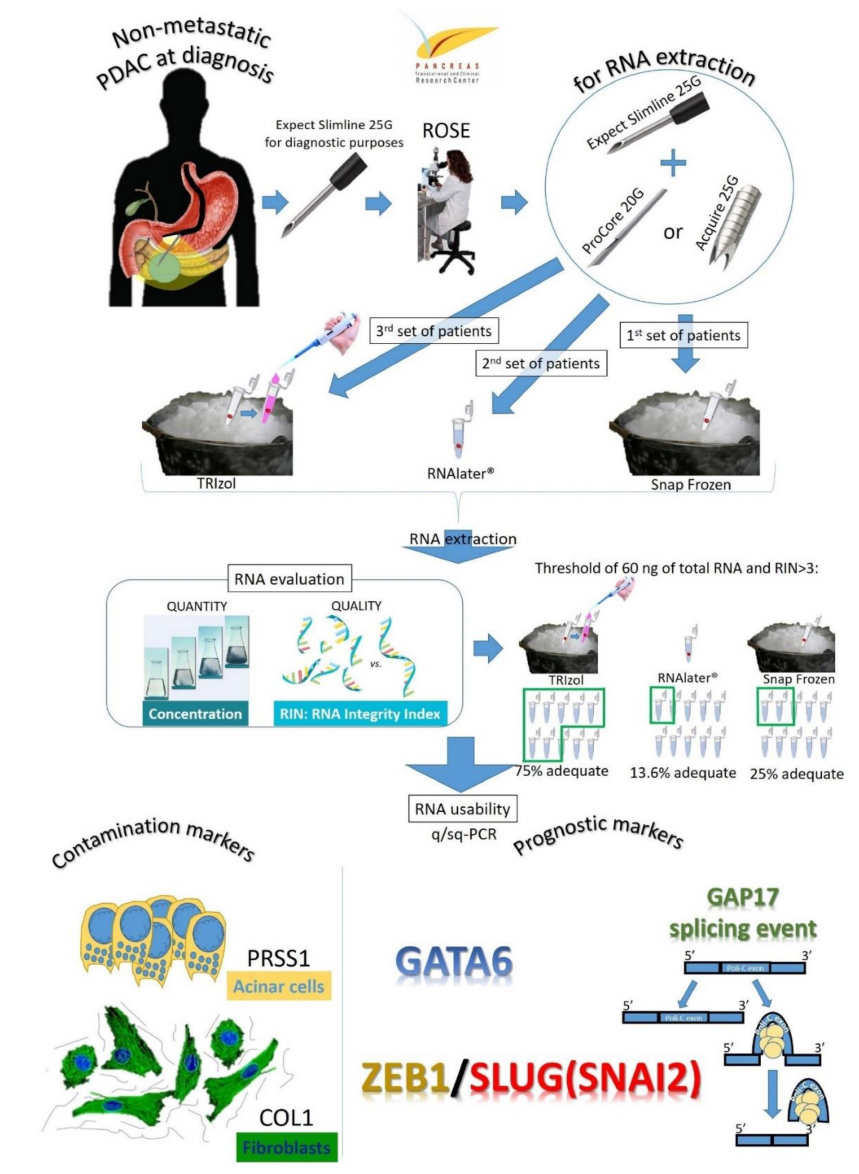
Figure 1. Explanatory representation of the study